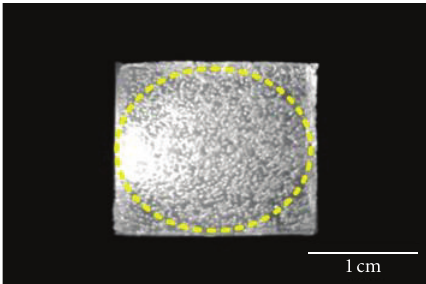
Figure 25: Schematic of the nine-spot